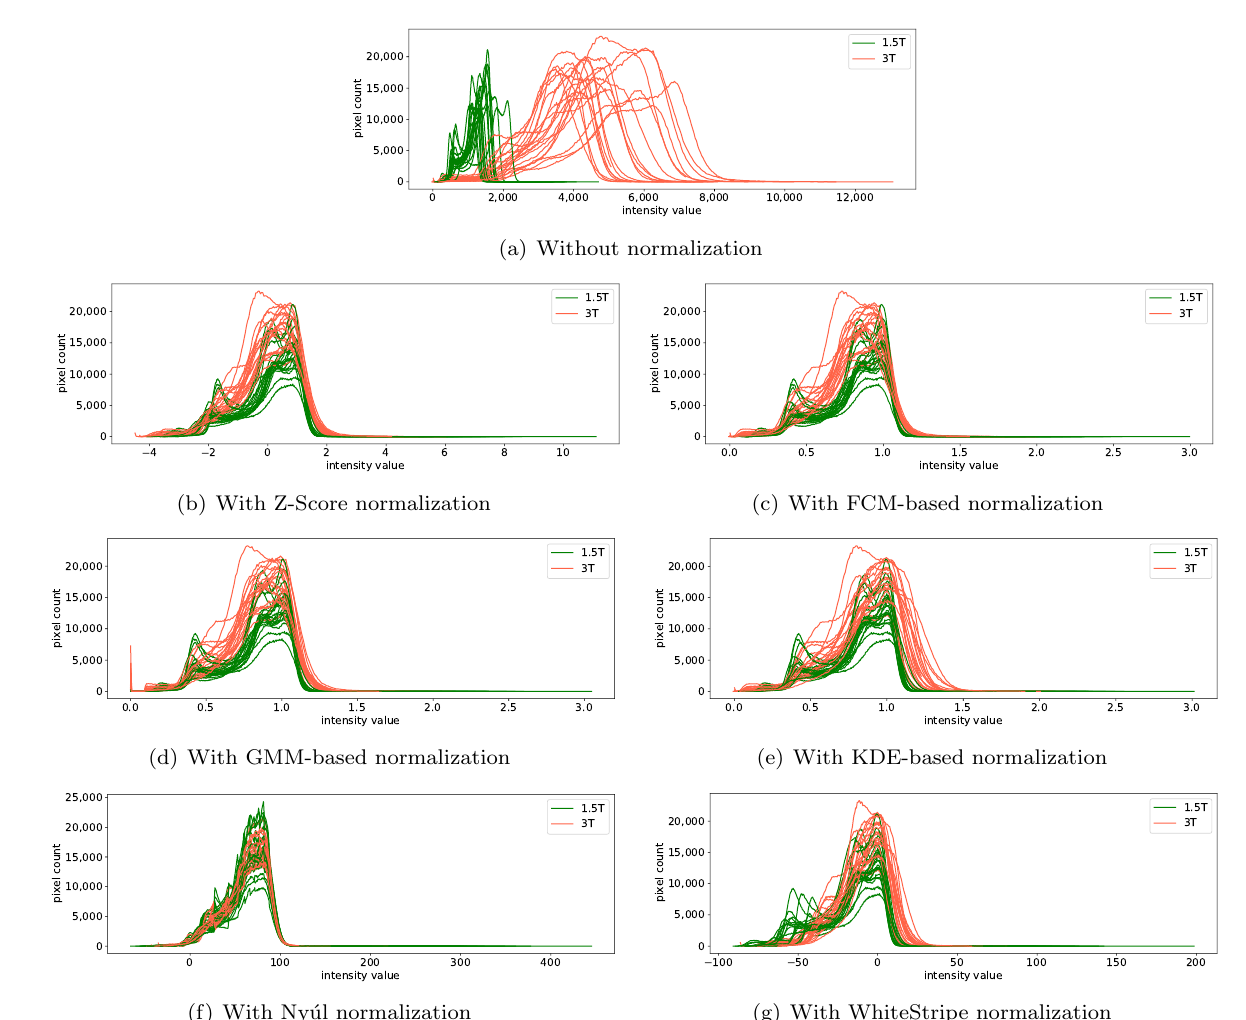
Figure 7. Impact of the intensity normalization methods on the image histograms of the brain MRI images of the clinical patient data, scanned by 1.5T and 3T scanner. The subfigures show the image histograms of the MRI images ( a ) without using any intensity normalization methods, ( b ) with using the Z-Score normalization, ( c ) with using the FCM-based normalization, ( d ) with using the GMM-based normalization, ( e ) with using the KDE-based normalization, ( f ) with using the Nyúl normalization and ( g ) with using the WhiteStripe normalization. Note that here image resampling were used as preprocessing method to alleviate the slight oscillation in original image